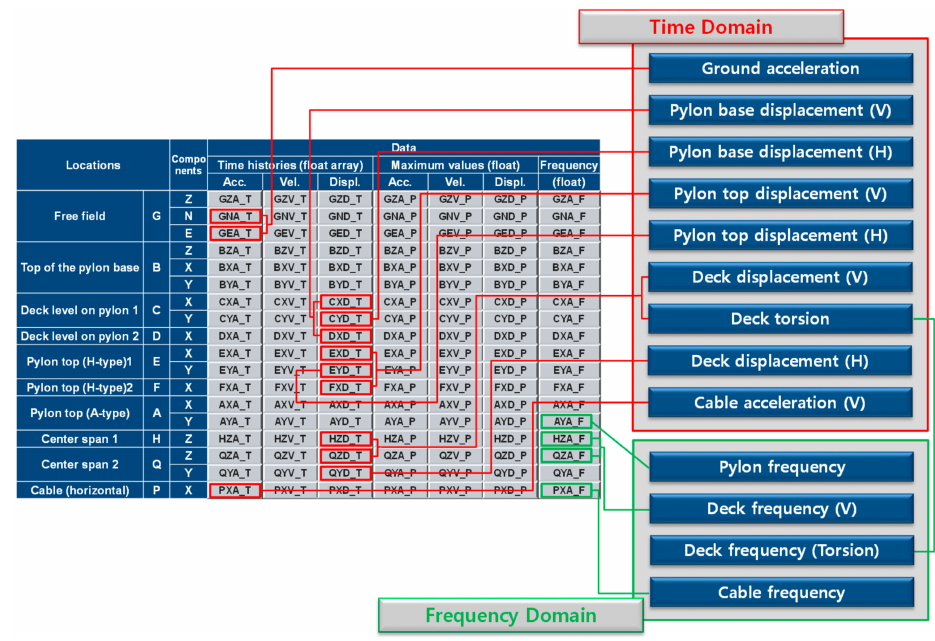
Figure 4. Overview of the data processing procedures and response indices.